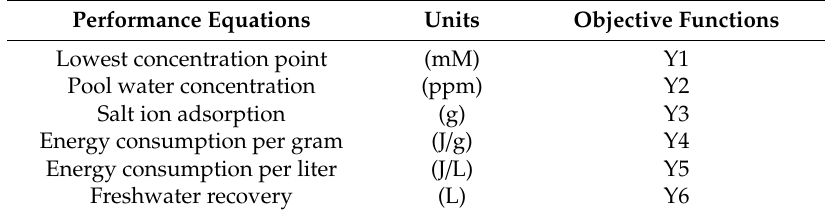
Table 2. Performance equations and corresponding objective functions for the optimization through radial movement optimization